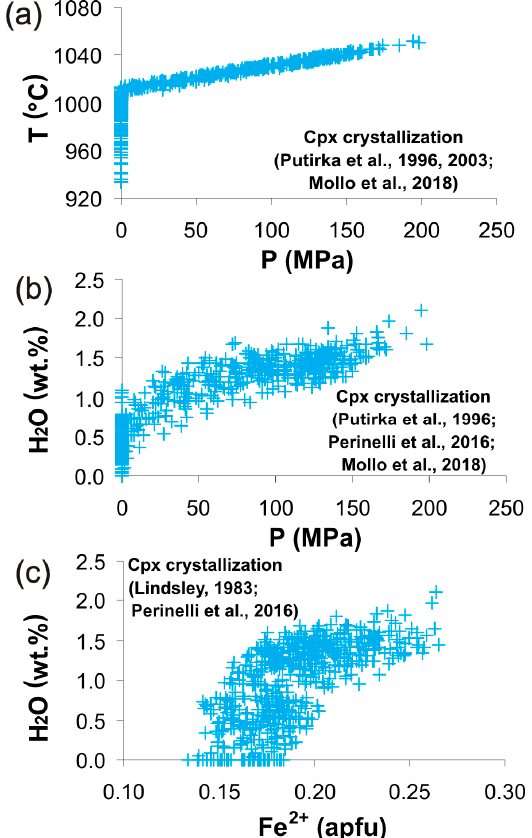
Figure 8. Temperatures ( a ), pressures ( a and b ) and melt-H 2 O contents ( b and c ) in equilibrium with clinopyroxene phenocrysts have been estimated by the H 2 O-independent thermometer (error ± 28 °C) and barometer (error ± 150 MPa) of Reference [39], Reference [69], recently refined for alkaline magmas by Reference [62], as well as the hygrometer (error ± 0.5 wt. % H 2 O) of Reference [84]. The Fe 2+ in clinopyroxene has been determined through the application of the stoichiometric formalism of Reference [38].